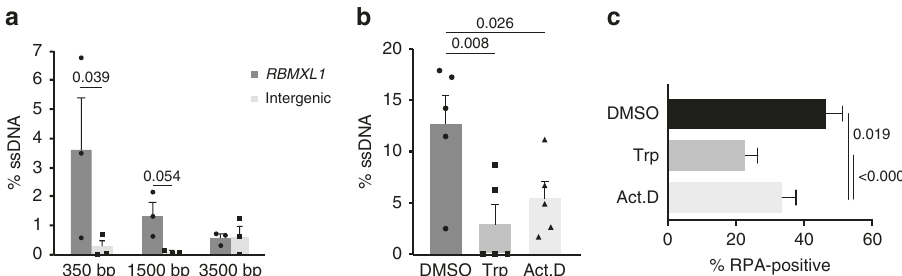
Fig. 7 Transcription facilitates DNA end resection. a DIvA cells were incubated for 4 h with 300 nM 4-OHT and DNA end resection was measured by qPCR at three positions upstream of an AsiSI cleavage site located in a silent, intergenic sequence. The plot compares the percentage of ssDNA at the intergenic locus with that calculated for the transcribed RBMXL1 locus in Fig. 3c. The error bars represent s.e.m. and statistical testing was done using a two-tailed Student ’ s t -test (n = 3 independent experiments). b DNA end resection at the RBMXL1 locus was also quanti fi ed in DIvA cells treated with either 10 µ M Triptolide for 30 min or 8 µ M ActD for 1 h. The plot shows the percentage of ssDNA 350 nt upstream of the AsiSI cleavage site in control cells (DMSO) and cells treated with RNAPII inbibitors. The error bars represent s.e.m. and statistical testing was done using a one-tailed Student ’ s t -test ( n = 5 independent experiments). c The effect of transcription inhibition on the formation of RPA foci was analysed in HeLa cells exposed to ionizing radiation (5 Gy) and stained with antibodies against RPA and γ -H2AX 15 min after irradiation. The bar plot shows the percentage of cells with γ H2AX-positive foci that were co- stained by RPA. Error bars show s.e.m. Statistical testing was done using a Mann – Whitney ’ s test ( n > 100 cells analysed in each condition, from four independent experiments). Source data for Fig. 7a – c are provided as a Source Data fi